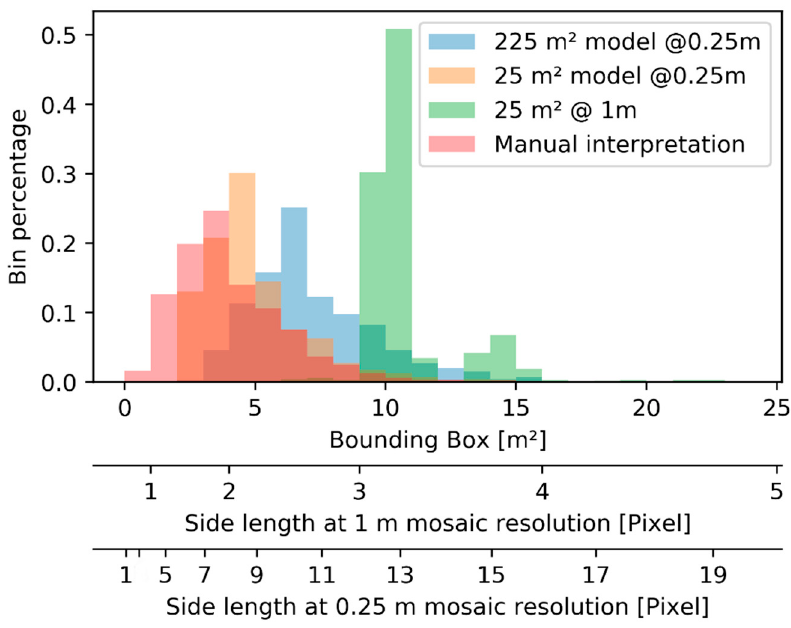
Figure 5. Histogram of the relative percentage of different bounding box areas of boulders and their shadows. The side length of a square object equivalent to the bounding box area is given for 0.25 m and 1 m backscatter mosaics. Bounding boxes for manual classification were determined from the training mosaics, the bounding boxes for the models are derived from the test mosaics.